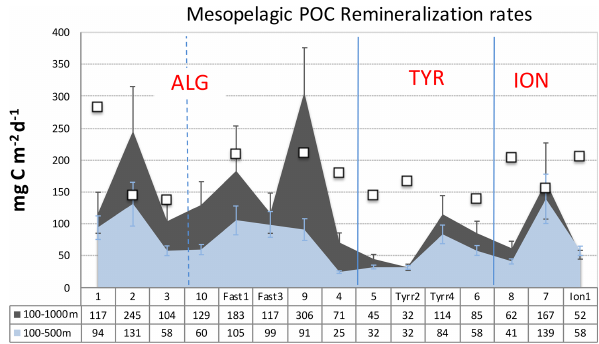
Figure 5. Integrated POC remineralization rates (mgCm − 2 d − 1 ) in the upper (100–500m depth) and entire (100–1000m depth) mesopelagic layer in the ALG, TYR and ION basins. Open squares represent primary production (mgCm − 2 d − 1 ; Van Wambeke et al.,